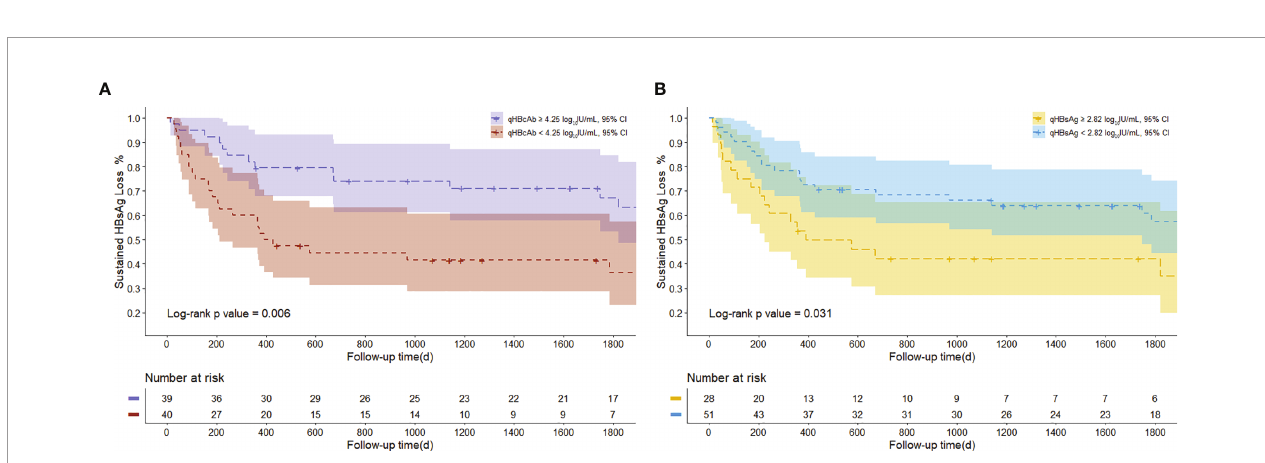
FIGURE 3 | Combined qHBcAb with qHBsAg as predictors of HBsAg recurrence. (A) The ROC curve of combined qHBcAb and qHBsAg at baseline. (B) Curves of the speci fi city, sensitivity and Youden index. The position of the black vertical dotted line shows the maximum Youden index that was used to predict HBsAg recurrence.